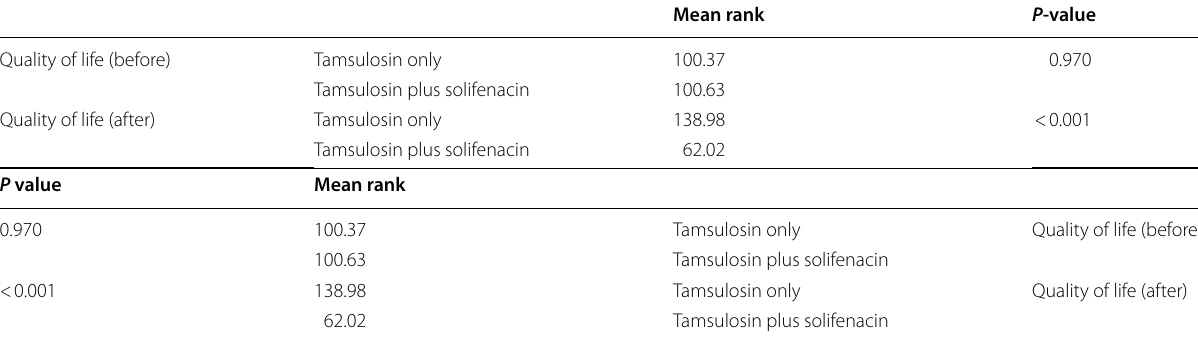
Quality of life (before)